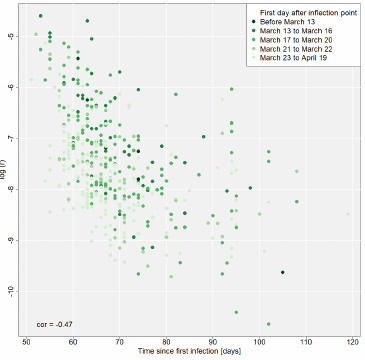
Figure 8: Growth rate and first day after inflection point vs. time